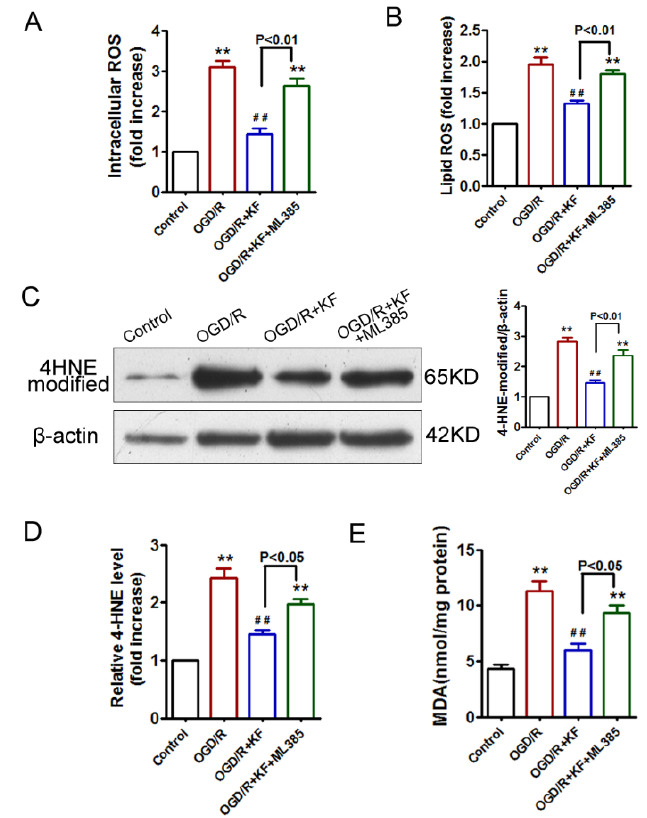
Figure 4. Effects of kaempferol on ROS, 4-HNE, and MDA levels in OGD/R-treated neurons. Neurons were treated as indicated in (Figure 1A). ( A ) Intracellular ROS production was measured with DCFH-DA. ( B ) Lipid ROS level was assessed by BODIPY-C11 staining. ( C ) 4-HNE-modified protein levels were detected by Western blot. ( D ) Levels of 4-HNE were tested by ELISA. Three independent experiments were performed with similar results. ( E ) Levels of MDA were investigated by ELISA. ** p < 0.01 versus control; ## p < 0.01 versus OGD/R.